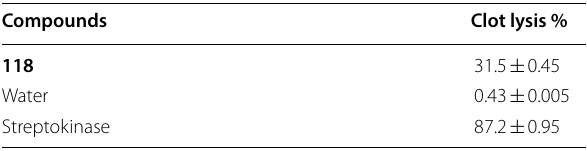
Table 25 Activity against metrazol convulsions for the compounds (114a, b, c), (115a, b, c, d, e),